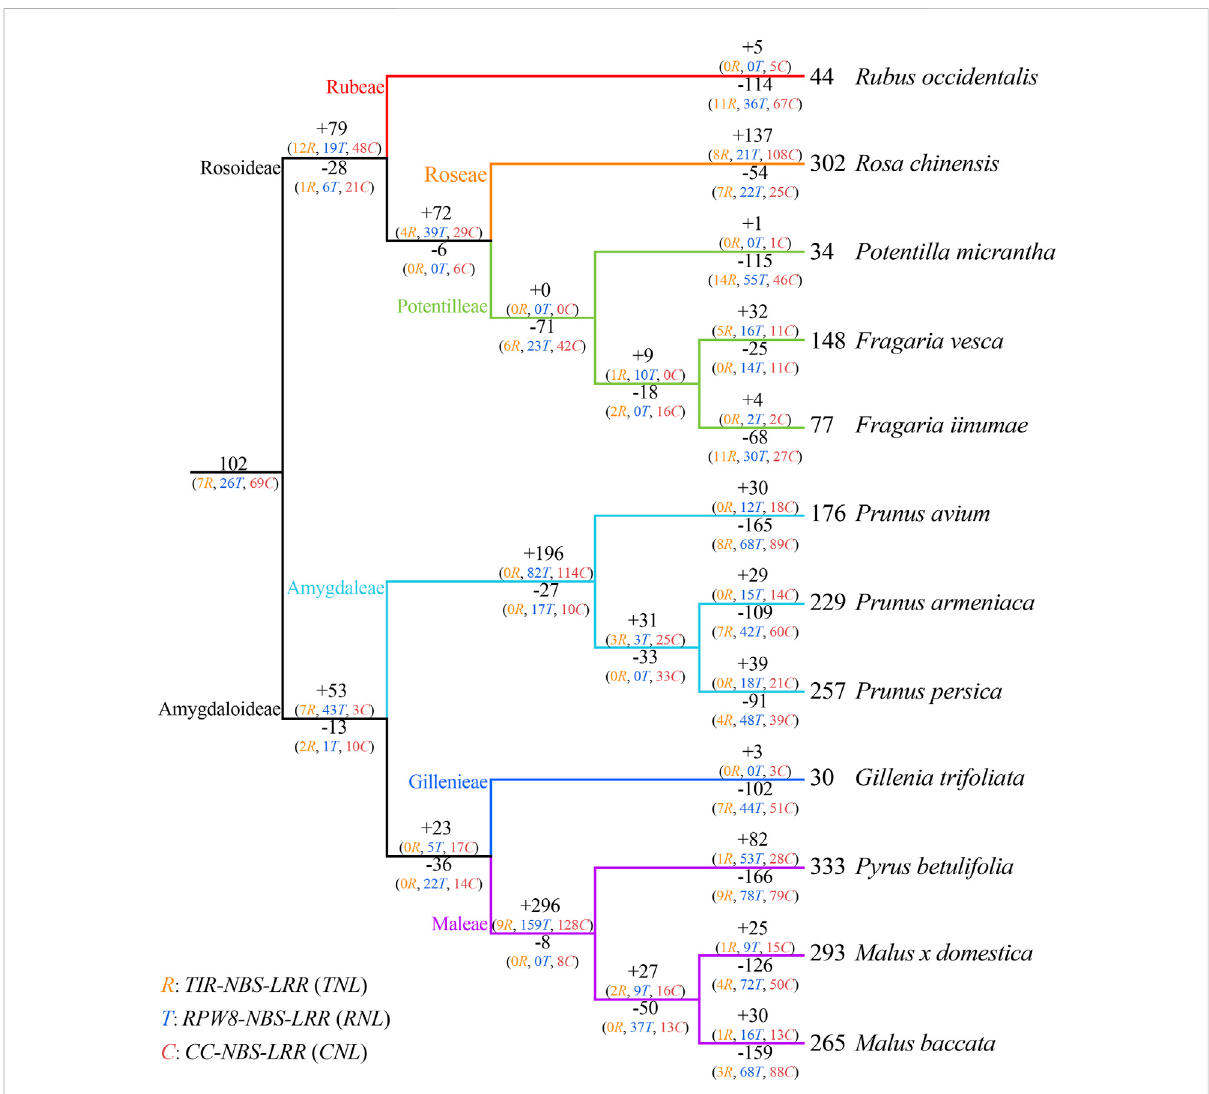
FIGURE 4 Duplication and loss events of NBS-LRR genes during Rosaceae evolution. Gene gains and losses are indicated by + or — symbols on each branch. Detailed information for gene gain and loss events is shown in Supplementary Figure S2.